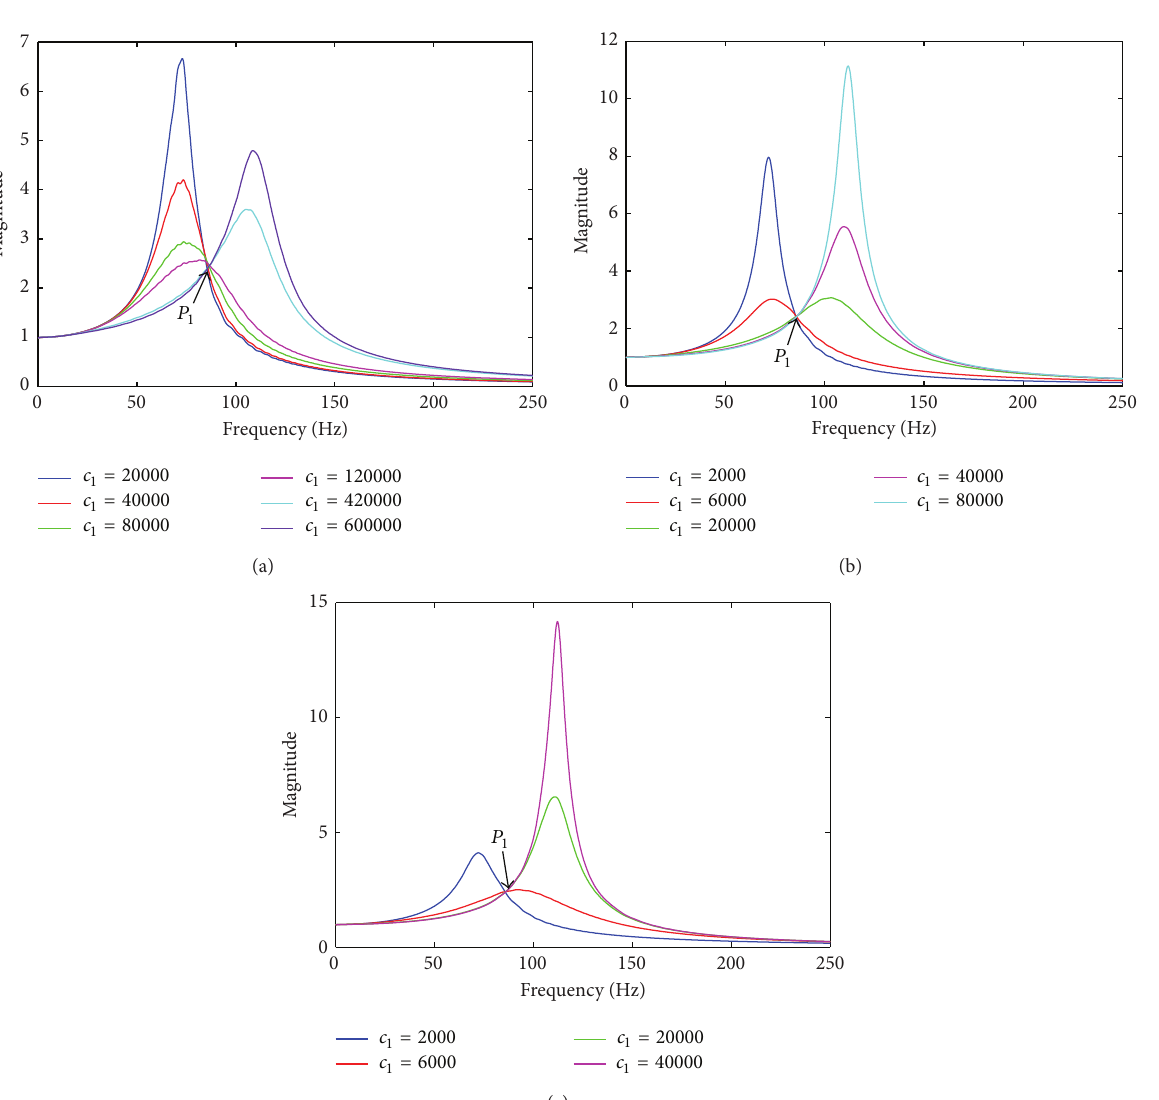
Figure 12: Force transmissibility curves of GNM under 50 N FE cases. (a) 𝑛 1 = 1.5 ; (b) 𝑛 1 = 1 Maxwell model; (c) 𝑛 1 = 0.85